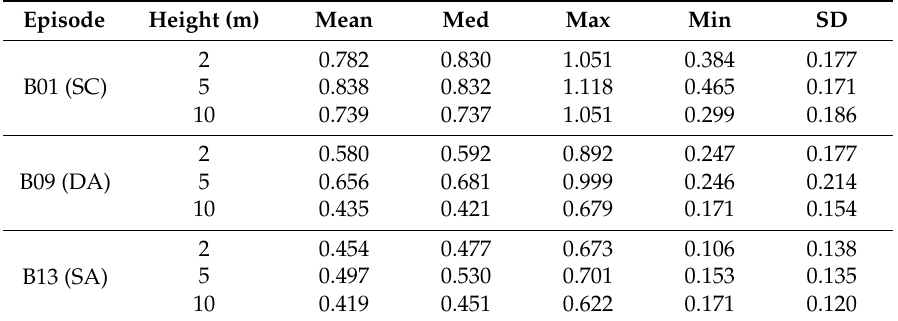
Table 3. The summary statistics of the friction velocity u ∗ (m · s –1 ) for each bora episode at selected vertical